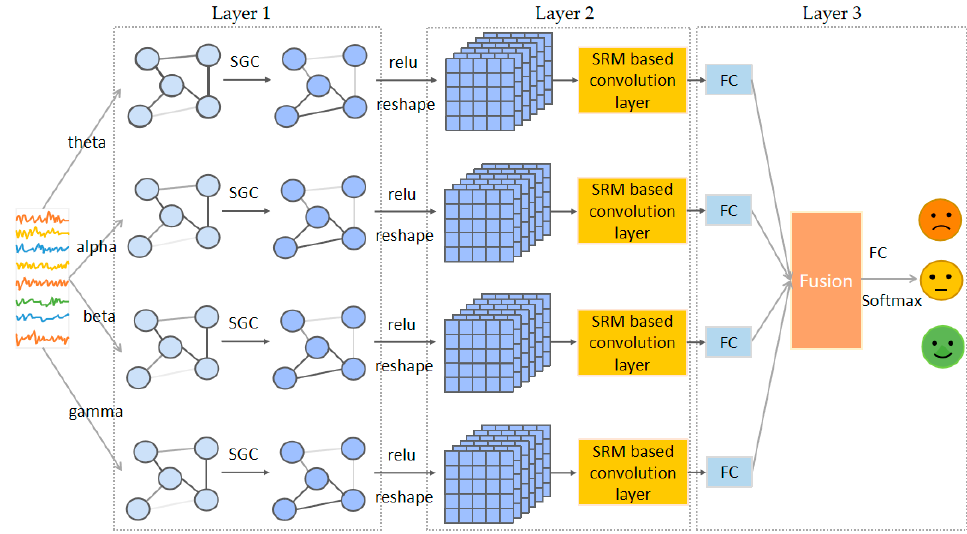
Figure 2. Framework diagram of SGC-SRM.